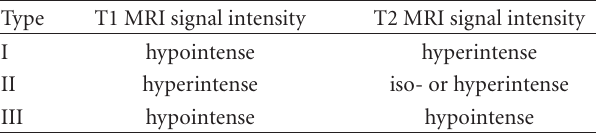
Table 1: Modic changes as illustrated by Jones et al. [23].